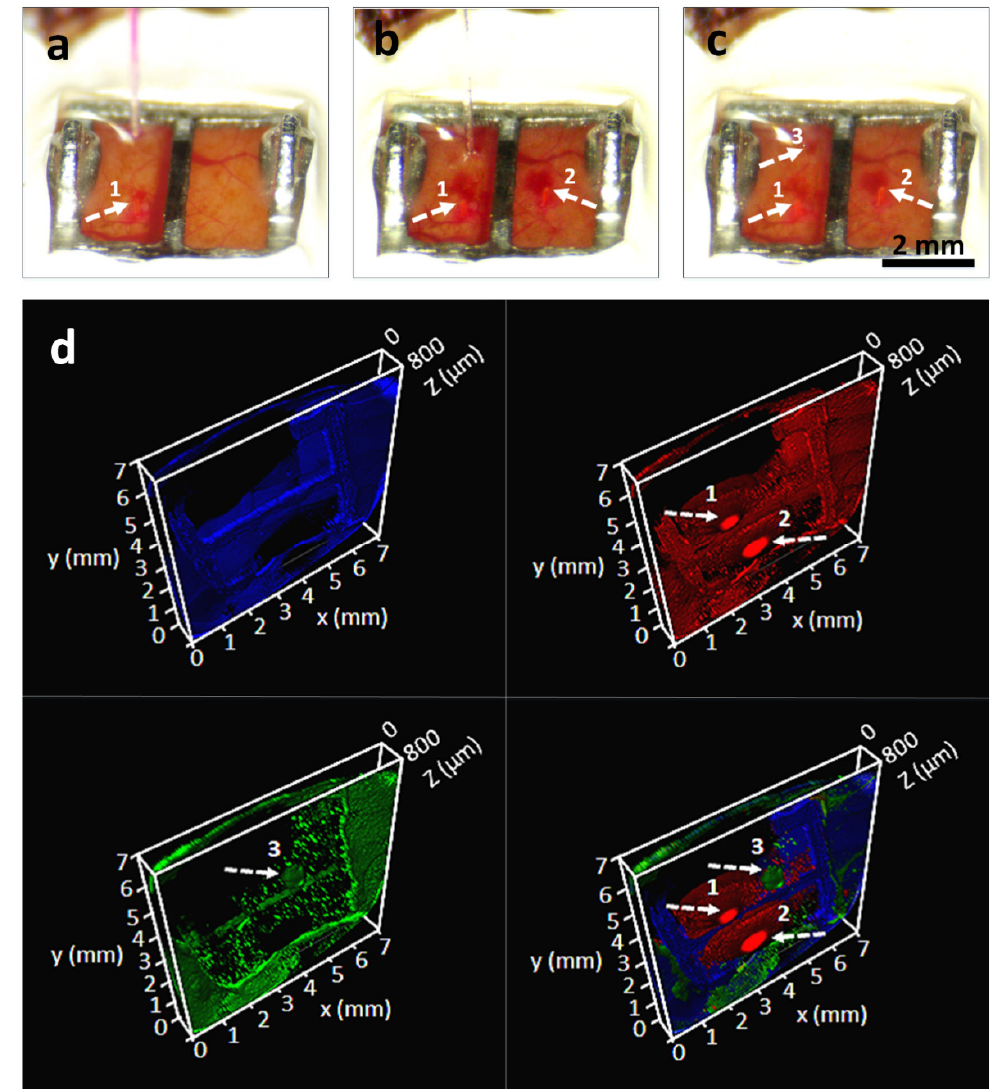
Figure 5. ( a – c ) Photographs for injections of DiI at spots 1 and 2 (0.1% in methanol, 0.2 µ L, 0.1 µ L min − 1) and fluorescence dye CTB488 (1 mg mL − 1 in PBS, 0.2 µ L, 0.1 µ L min − 1 ) at spot 3 through a Ti-PDMS cranial window implanted on a mouse head. ( d ) Confocal imaging micrographs for the injected spots after two days. Adapted with permission from [63]. 2022, Nana Yang et